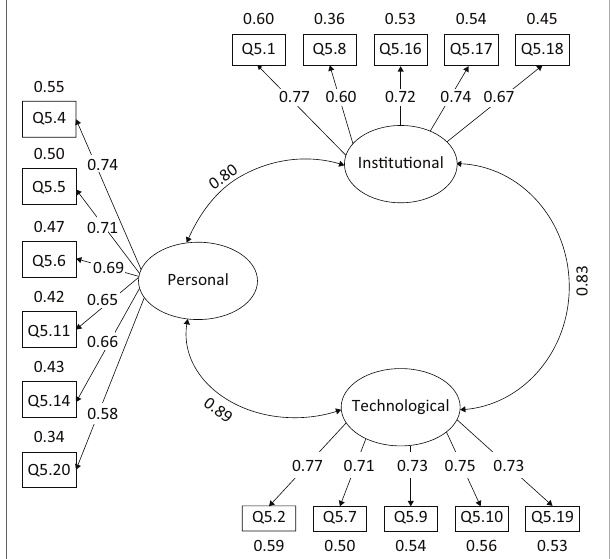
FIGURE 3: The refined